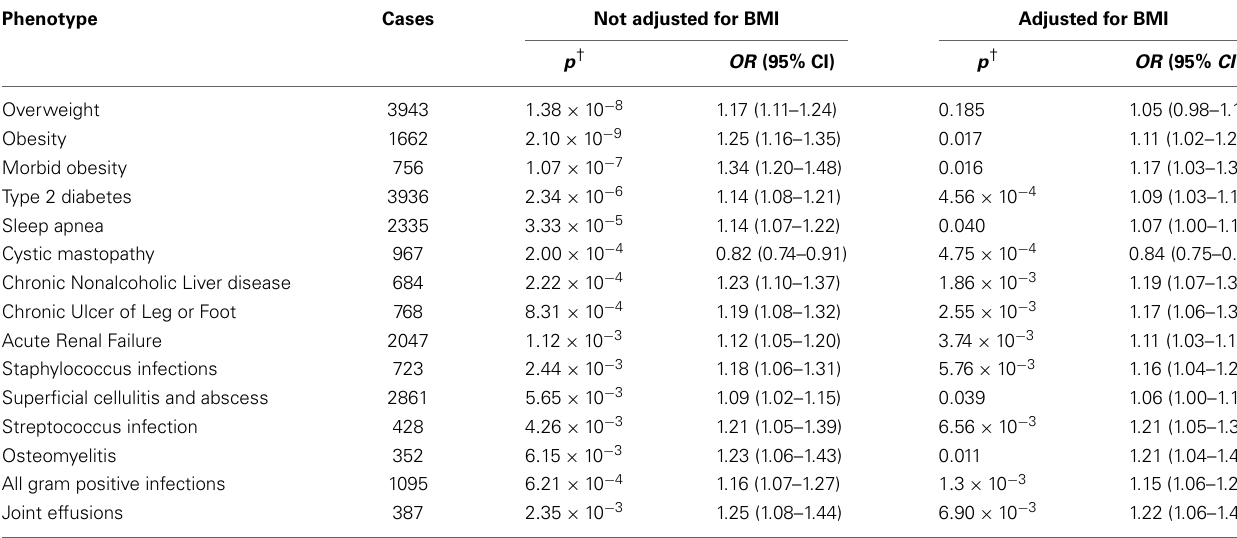
Table 3 | Meta-analysis PheWAS results for rs8050136 with and without adjustment for average